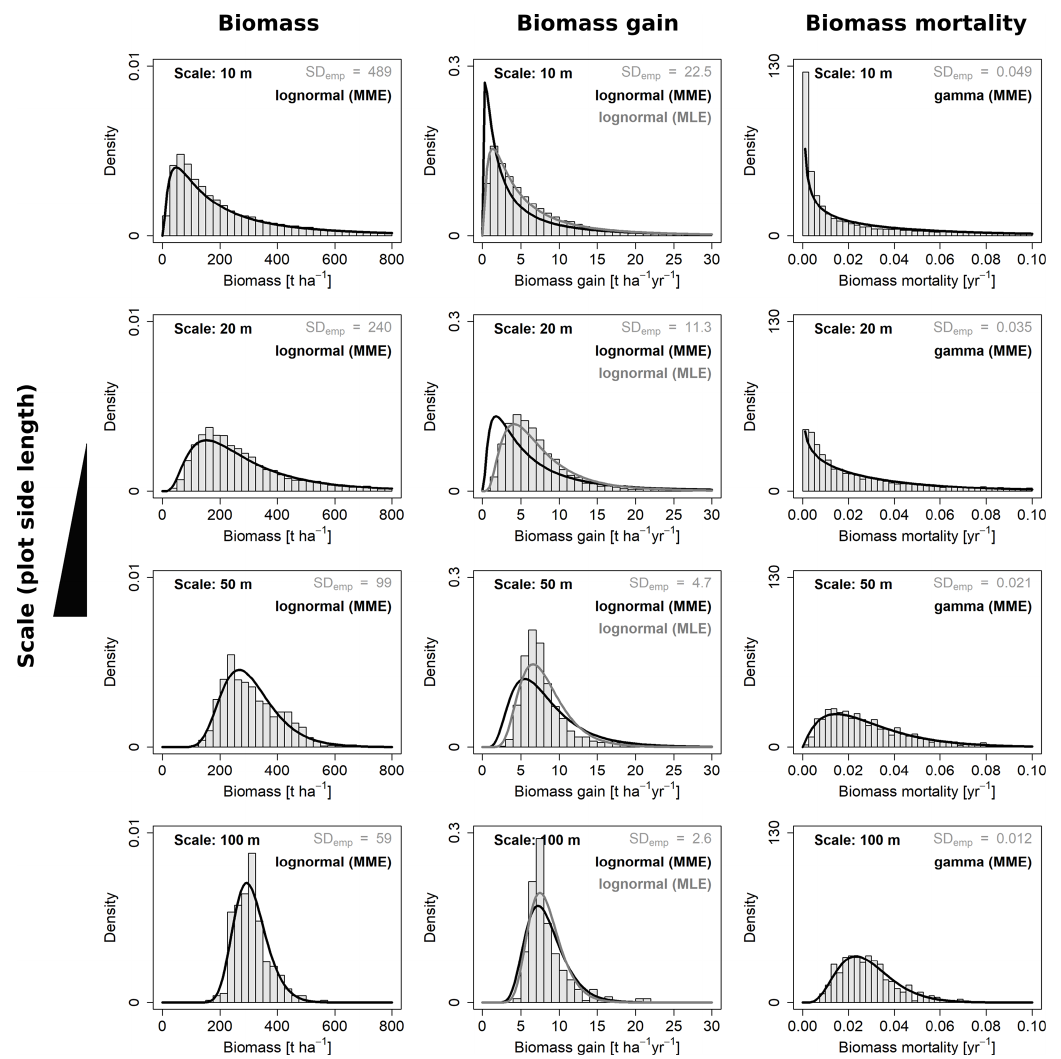
Figure 4. Frequency distributions for aboveground biomass and its gain and mortality analyzed at four different scales. Shown are the best- fitting probability density functions for each of the three variables at each scale and the respective empirical distributions from the field (grey histograms). For AGB gain, each of the two fitting methods (MME and MLE) were superior regarding one criterion; hence, curves are plotted for